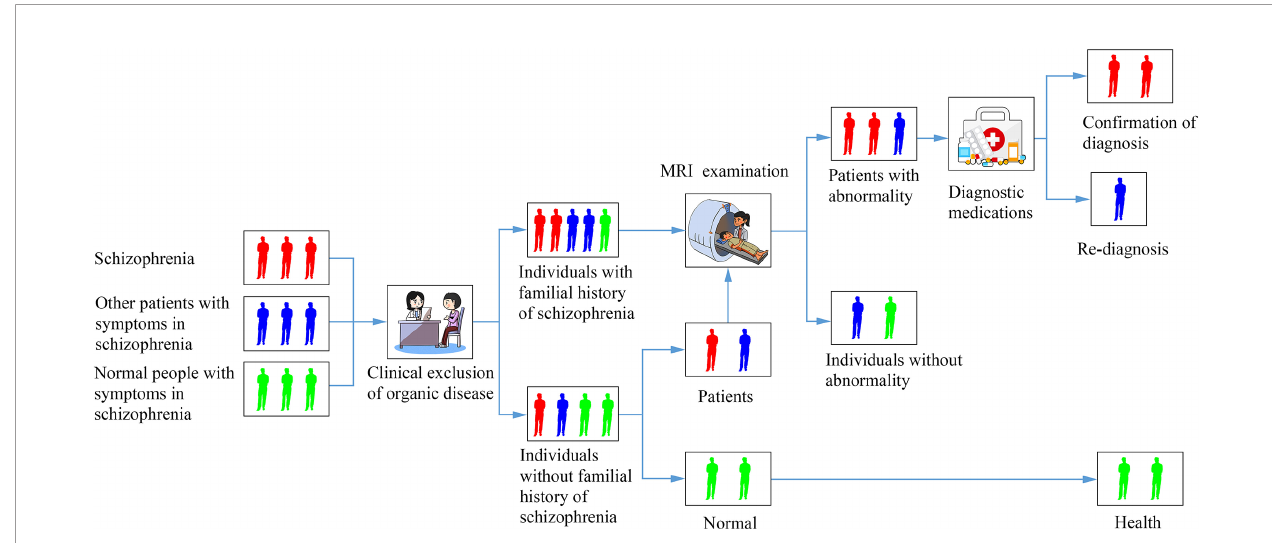
FIGURE 1 | A diagram of a fl owchart for identifying a patient with schizophrenia based on